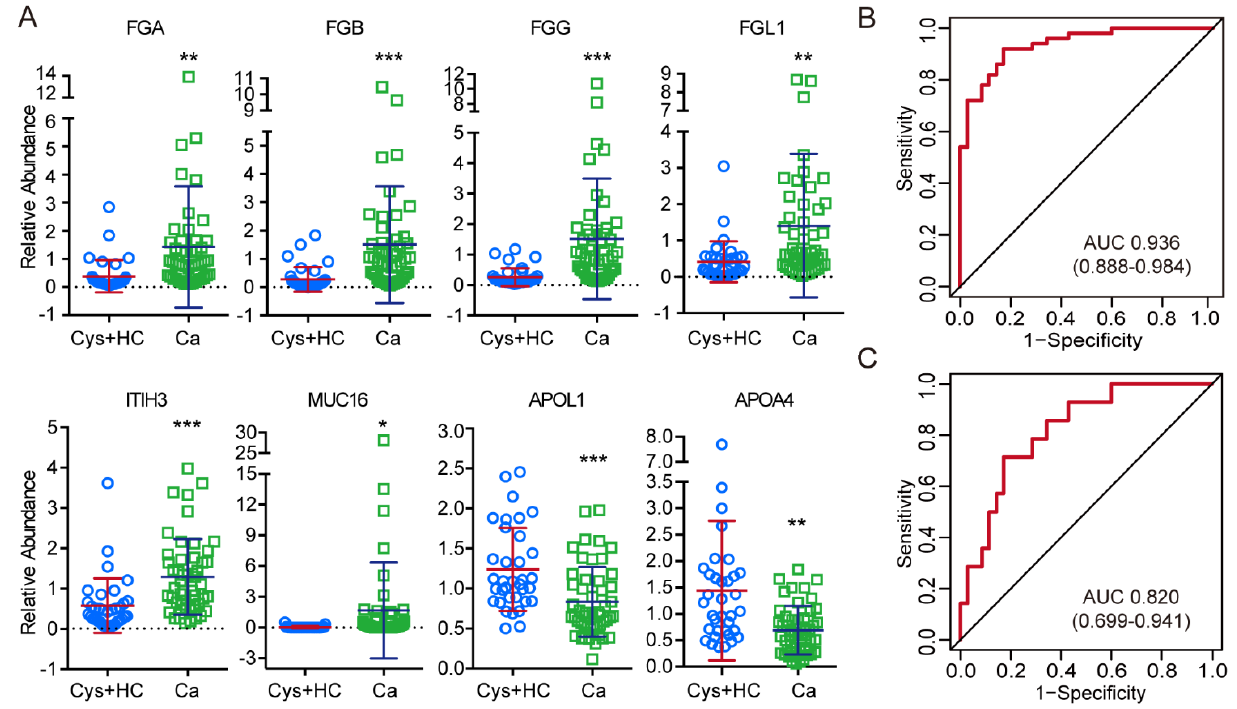
Figure 6. Development of a protein panel for liquid biopsy of ovarian cancer. ( A ) Scatter plots of quantitative comparisons between the Ca group and the HC/Cys group for indicators with potential diagnostic value for ovarian cancer. The blue circles represent relative quantification values for cystadenomas and healthy controls. Green boxes represent relative quantification values for ovarian cancer patients. * p < 0.05, ** p < 0.01, *** p < 0.001. ( B ) ROC analysis of the novel model to diagnose ovarian cancer in a general population. Multivariate logistic regression analysis was performed in all patients to establish a screening diagnostic model followed by receiver operating curve analysis. Table 3. Area under the ROC curve of proteins for diagnosis of ovarian cancer. Table 4. Univariate logistic regression analysis for the prediction of ovarian cancer.